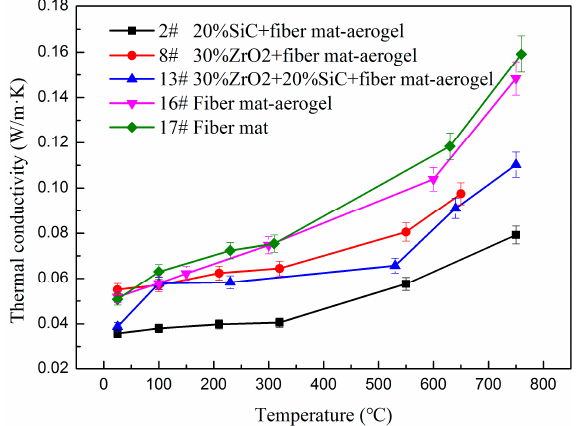
Figure 3. Thermal conductivity comparison at high temperature.